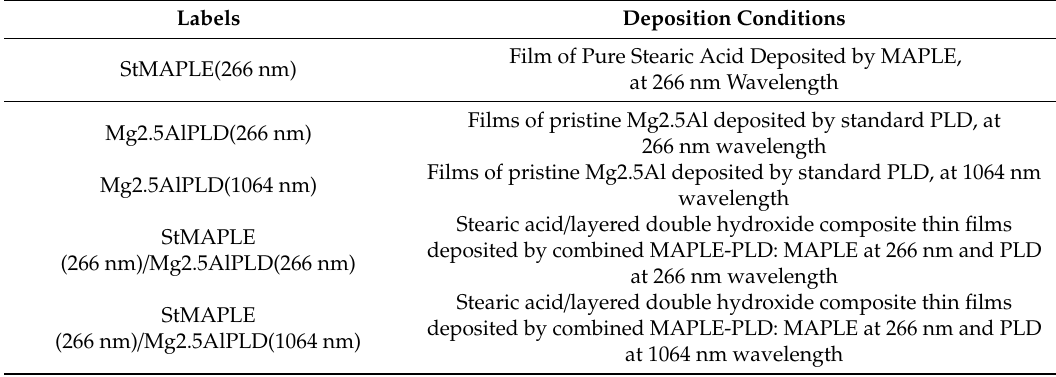
Table 1. The codes used for the films and their corresponding deposition conditions.